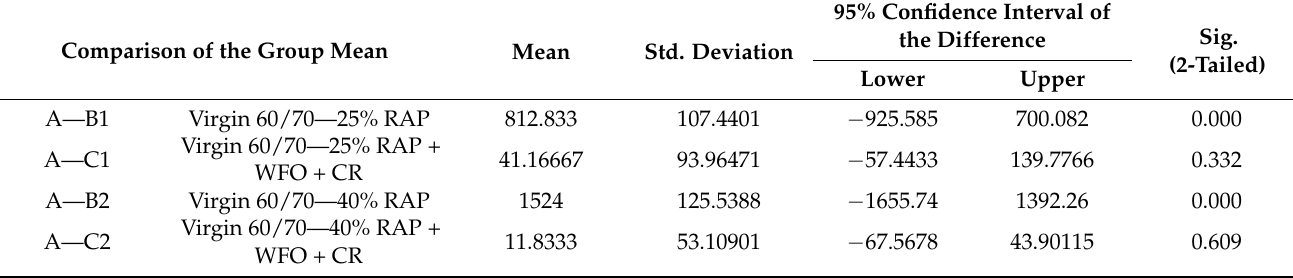
Table 17. The significant difference in the group means for the resilient modulus of the virgin asphalt with RAP and the recycled asphalt mixture at 40 ◦ C.